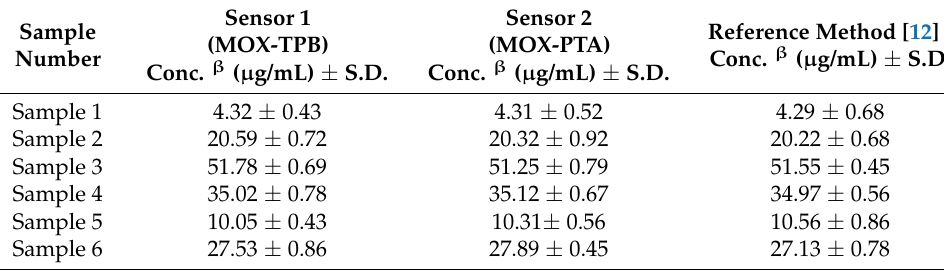
Table 5. Determination of MOX in real wastewater samples from pharmaceutical industrial